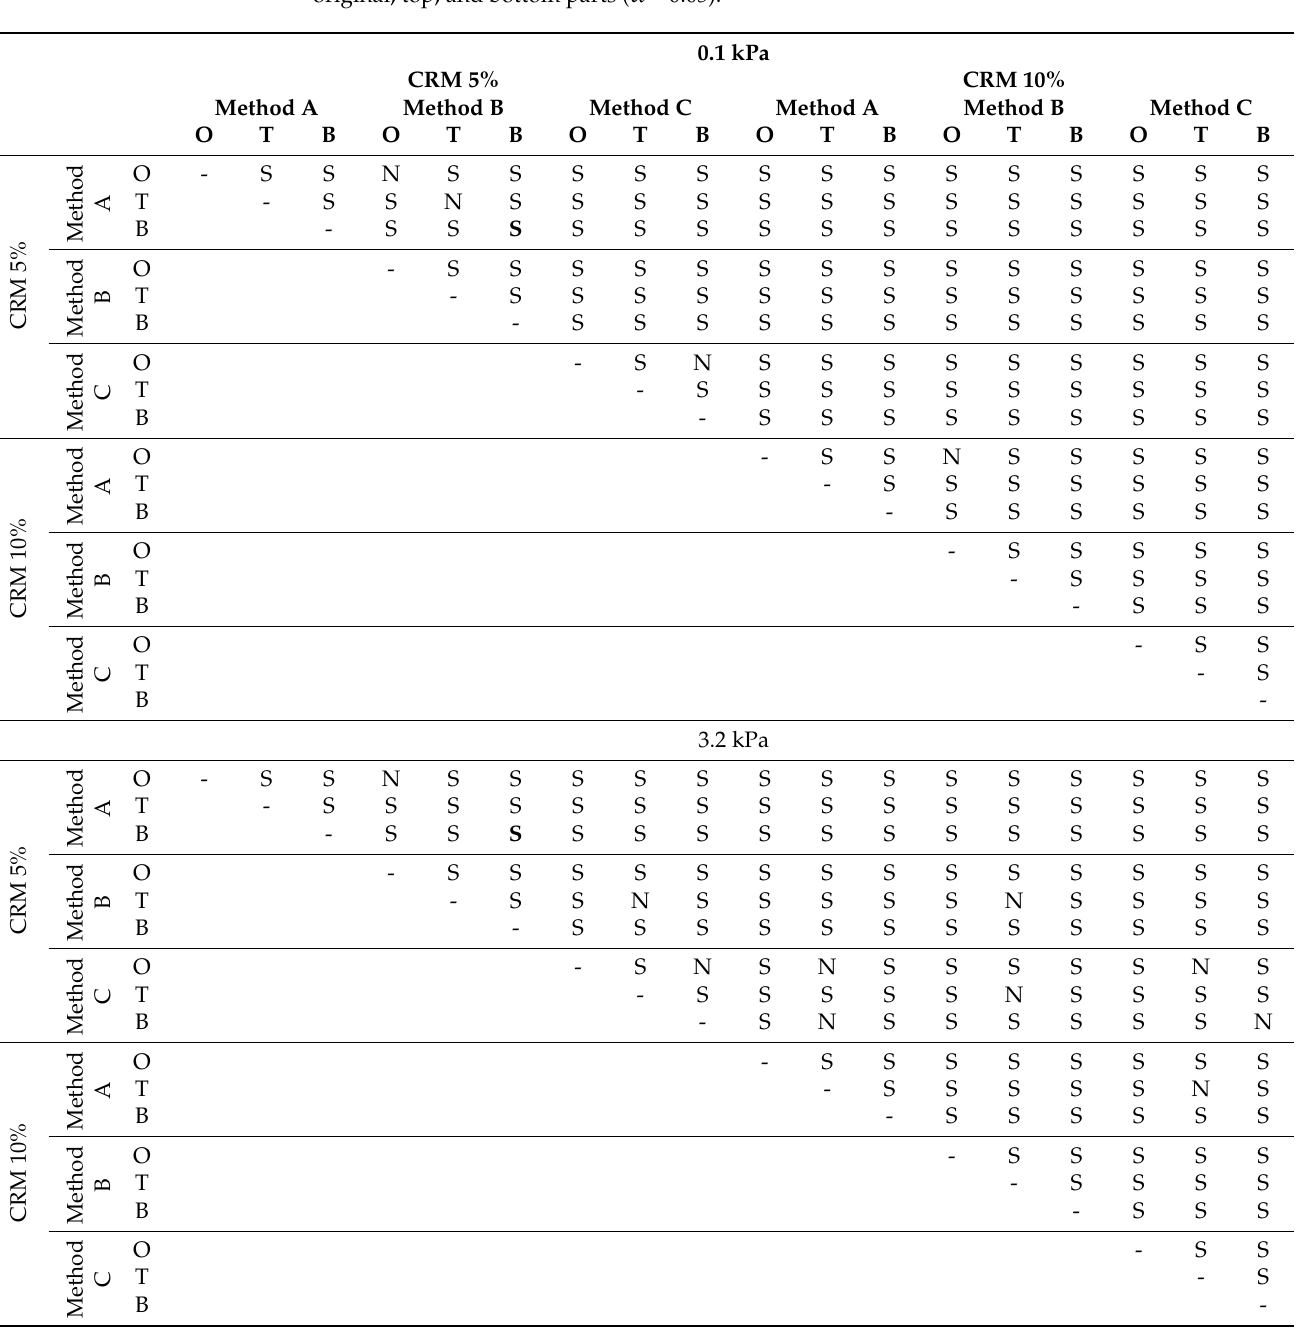
Table 5. Statistical analysis results of percentage recovery of the CRM binders as a function of the original, top, and bottom parts ( α =